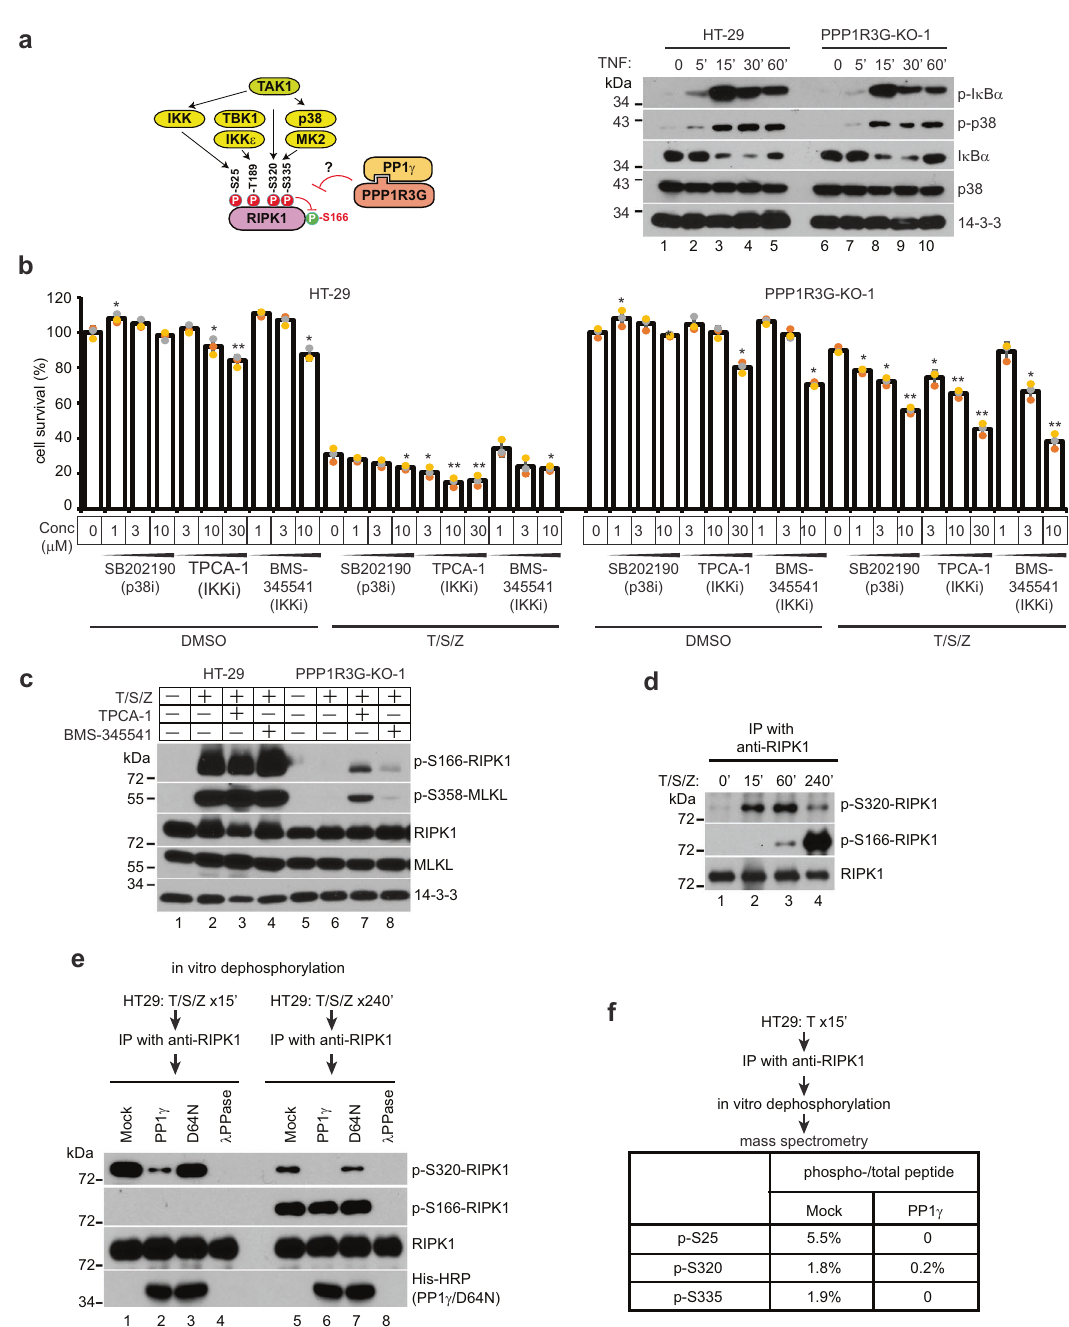
Fig. 5 PPP1R3G/PP1 γ directly removes inhibitory phosphorylations of RIPK1 to activate RIPK1 and cell death. a Left panel, diagram of how RIPK1 kinase activity is regulated by inhibitory phosphorylations. Serine 166 is an auto-phosphorylation site of RIPK1, serving as a readout of RIPK1 kinase activation. Right panel, cells were treated with TNF for different durations and cell lysates were subjected to Western blotting with indicated antibodies. p-I κ B α detects phosphorylated serine 32 of I κ B α , and p-p38 detects phosphorylated Thr180/Tyr182 of p38. b HT-29 and PPP1R3G-KO-1 cells were treated with DMSO or T/S/Z, in the presence of an increasing concentration of different inhibitors, followed by CellTiter-Glo assay. Viable cells expressed as a percentage of DMSO-treated cells. SB202190 is a p38 inhibitor, and TPCA-1, BMS345541 are IKK inhibitors. Results are represented as mean ± SD of n = 3 biological independent samples. * t -test, P < 0.05; ** t -test, P < 0.01. c HT-29 and PPP1R3G-KO-1 cells were treated with DMSO, T/S/Z, or T/S/Z with 30 µ M TPCA-1 or 10 µ M BMS345541 for 4 h. Western blotting was performed with the indicated antibodies. d HT-29 cells were treated with T/S/Z for indicated periods and cell lysates were harvested and subjected to IP with an anti-RIPK1 antibody, followed by Western blotting. p-S320-RIPK1 detects phosphorylated S320 of RIPK1. e HT-29 cells were treated with T/S/Z for 15 min or 240 min and cell lysates were subjected to anti-RIPK1 IP. RIPK1-bound beads were then incubated with recombinant PP1 γ , D64N mutant of PP1 γ , or lambda phosphatase ( λ PPase), followed by Western blotting. f In vitro dephosphorylation was performed as in ( e ) and the fi nal products were subjected to mass spectrometry analysis. The percentage of each phospho-peptide was